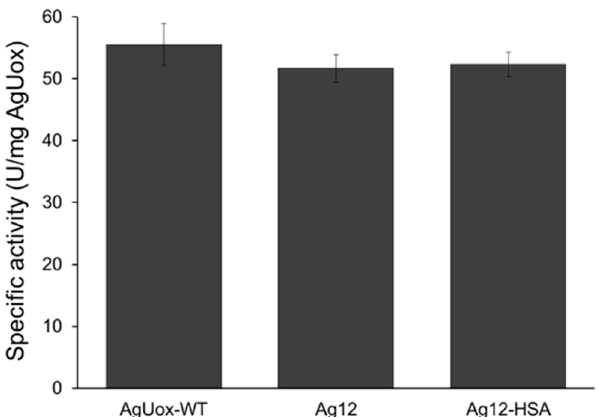
Figure 7. Specific activity of AgUox-WT, Ag12, and Ag12-HSA. Experiments were performed in quadruplicate, and error bars indicate the standard deviation.